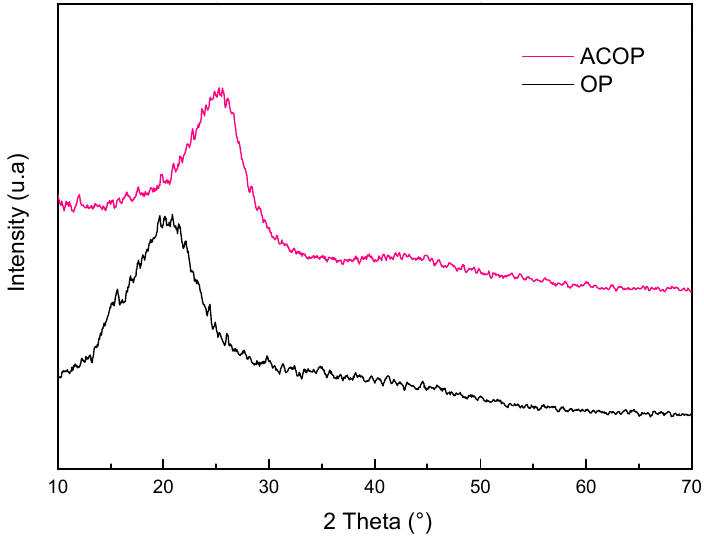
Figure 2. X-ray diffractograms of OP and ACOP samples.